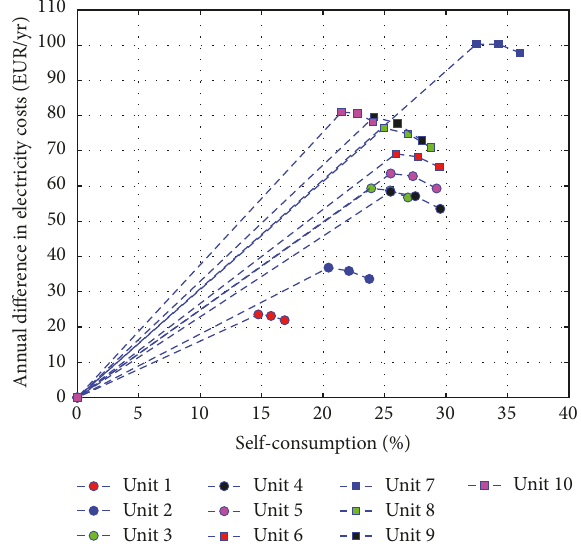
Figure 15: German retail electricity prices: comparison of annual electricity costs.